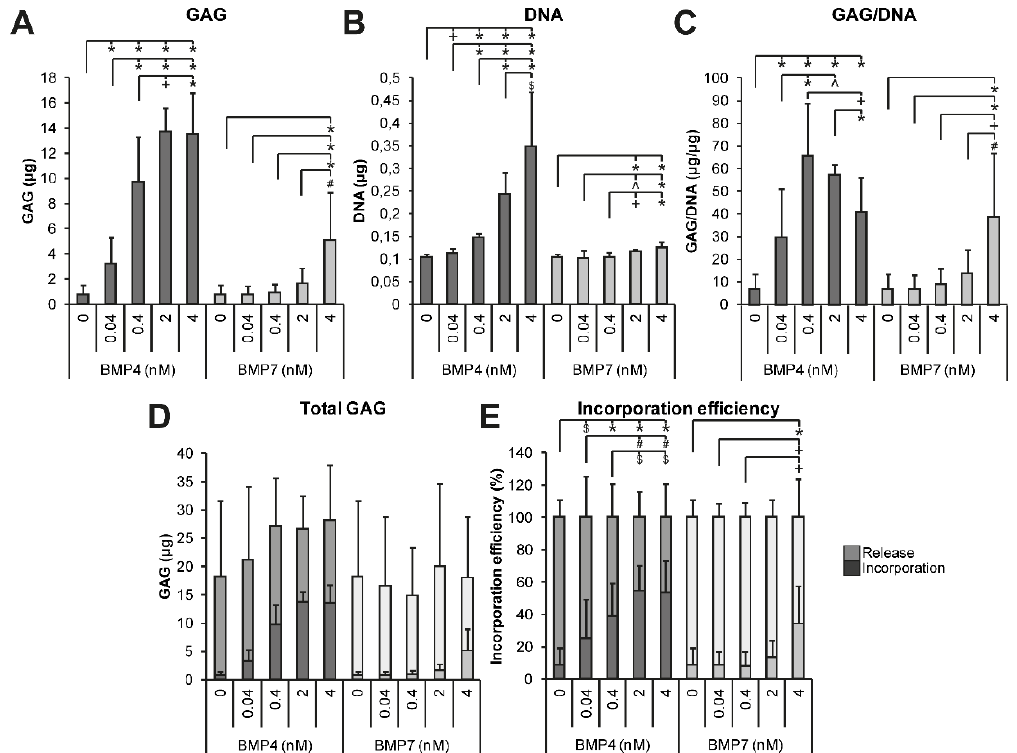
Figure 3. Dose response of human degenerated nucleus pulposus (NP) cells of 4 donors ( n = 12;